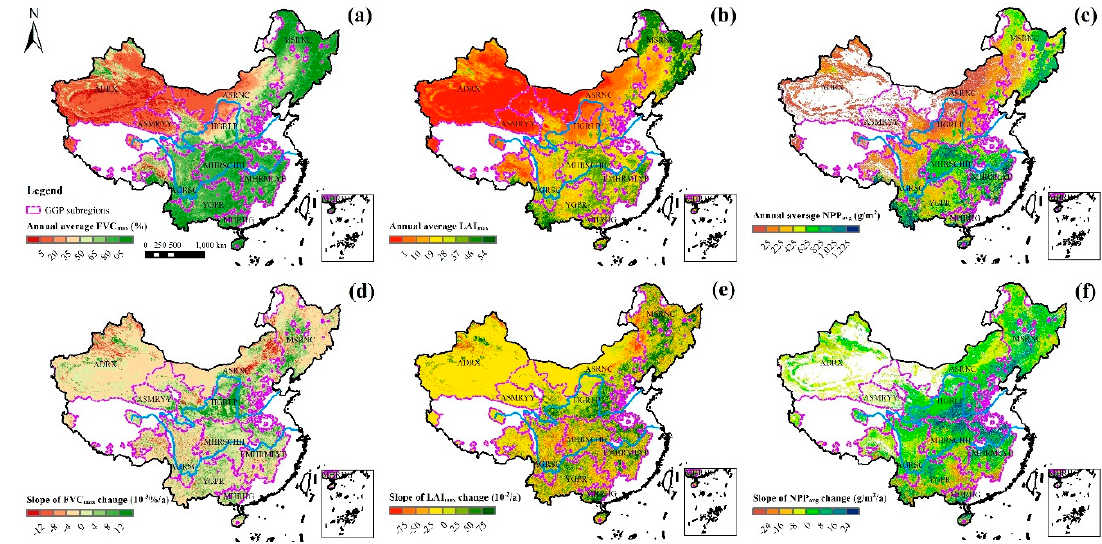
Figure 4. Spatial pattern of annual average ecosystem quality (EQ) and slope of EQ change in the Grain for Green Program (GGP) area from 2000 to 2010. ( a ), ( b ), and ( c ) are the annual average FVC max , LAI max , and NPP avg , respectively; ( d ), ( e ), and ( f ) refer to the slope of annual FVC max , LAI max , and NPP avg changes, respectively.